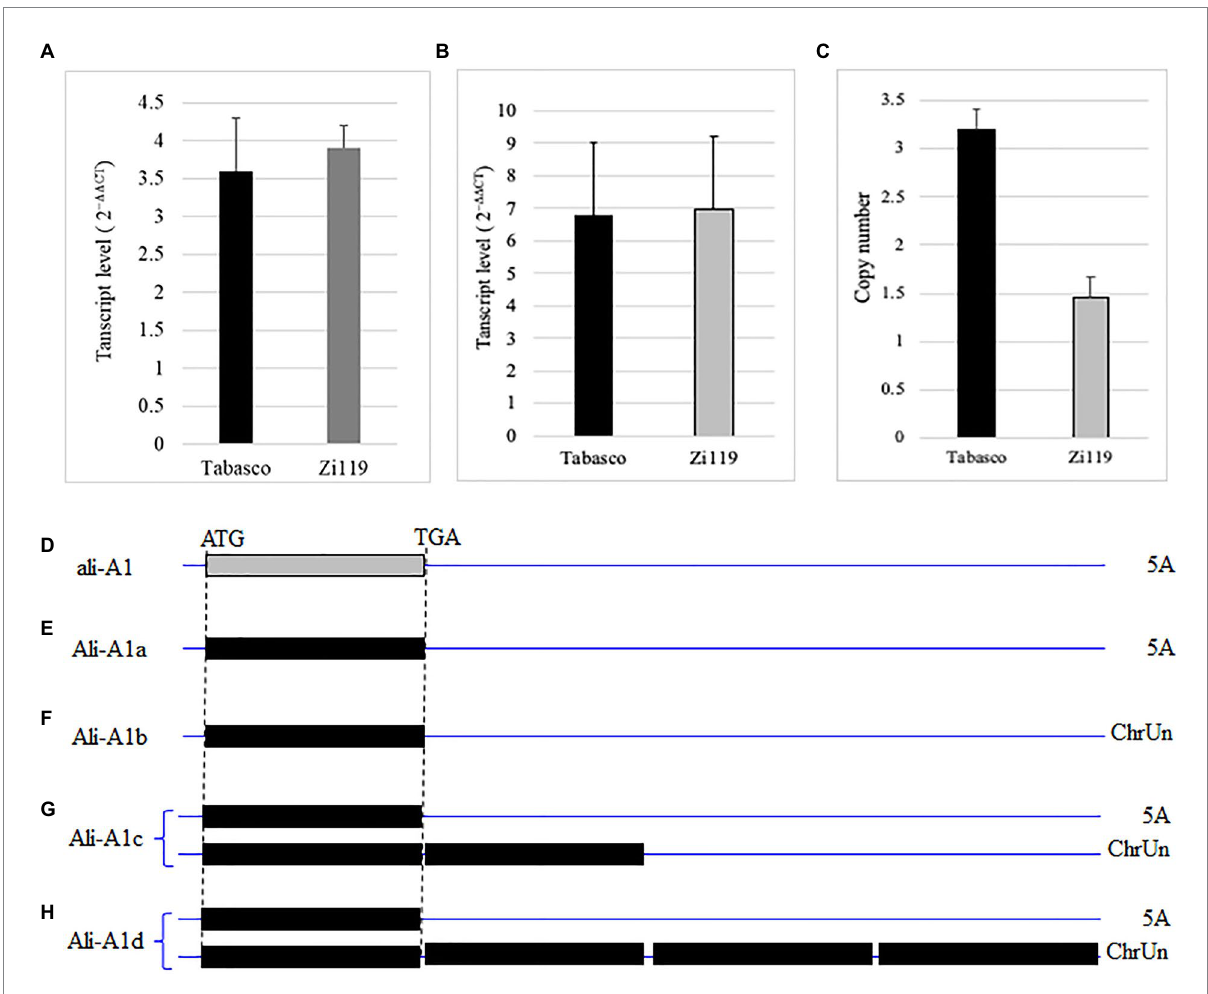
FIGURE 5 Transcript levels and copy number of different ALI-A1 alleles. (A) Comparison of ALI-A1 transcript levels in leaves between the Tabasco allele and the Zi119 allele. (B) Comparison of ALI-A1 transcript levels in young spikes between the Tabasco allele and the Zi119 allele. (C) Comparison of ALI-A1 copy number between the Tabasco allele and the Zi119 allele. (D–H) Copy number and chromosomal locations of ALI-A1 in CS and 10 wheat genome sequences. (D) The Ali-A1 allele was found to have one copy on chromosome 5A in six cultivars including CS at position 700,824,508